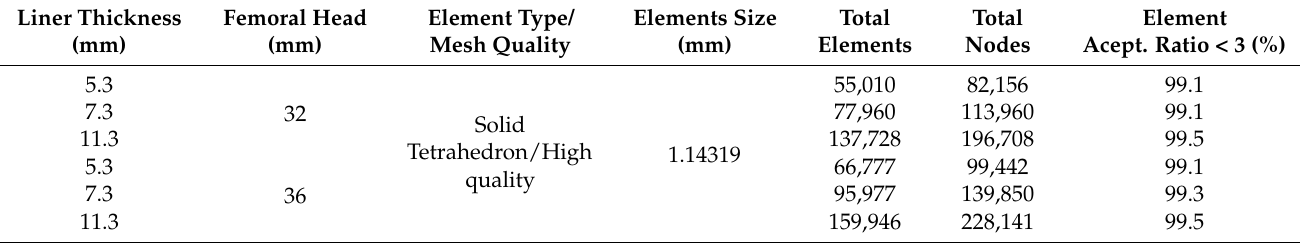
Table 2. Mesh liner details for FEA in all